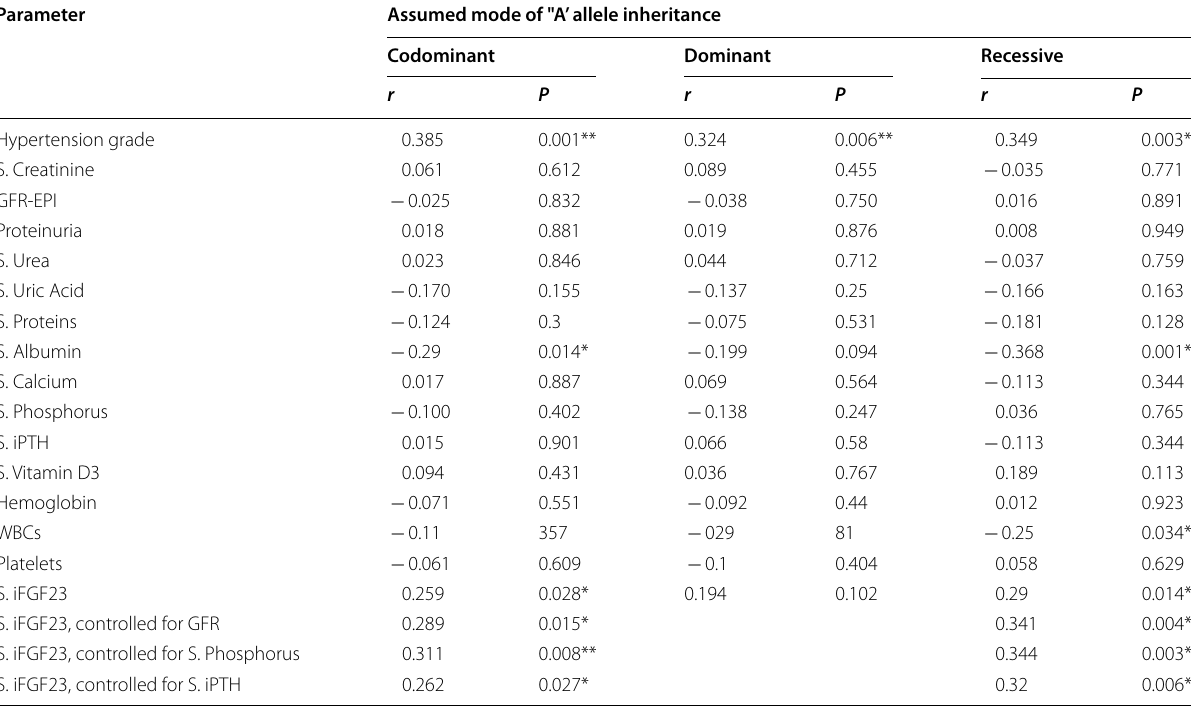
CKD, chronic kidney disease; S., serum; GFR-EPI, glomerular filtration rate by CKD epidemiology collaboration equation; iPTH, intact parathyroid hormone; iFGF23, intact fibroblast growth factor 23; WBCs, white blood cells; r , Spearman correlation coefficient